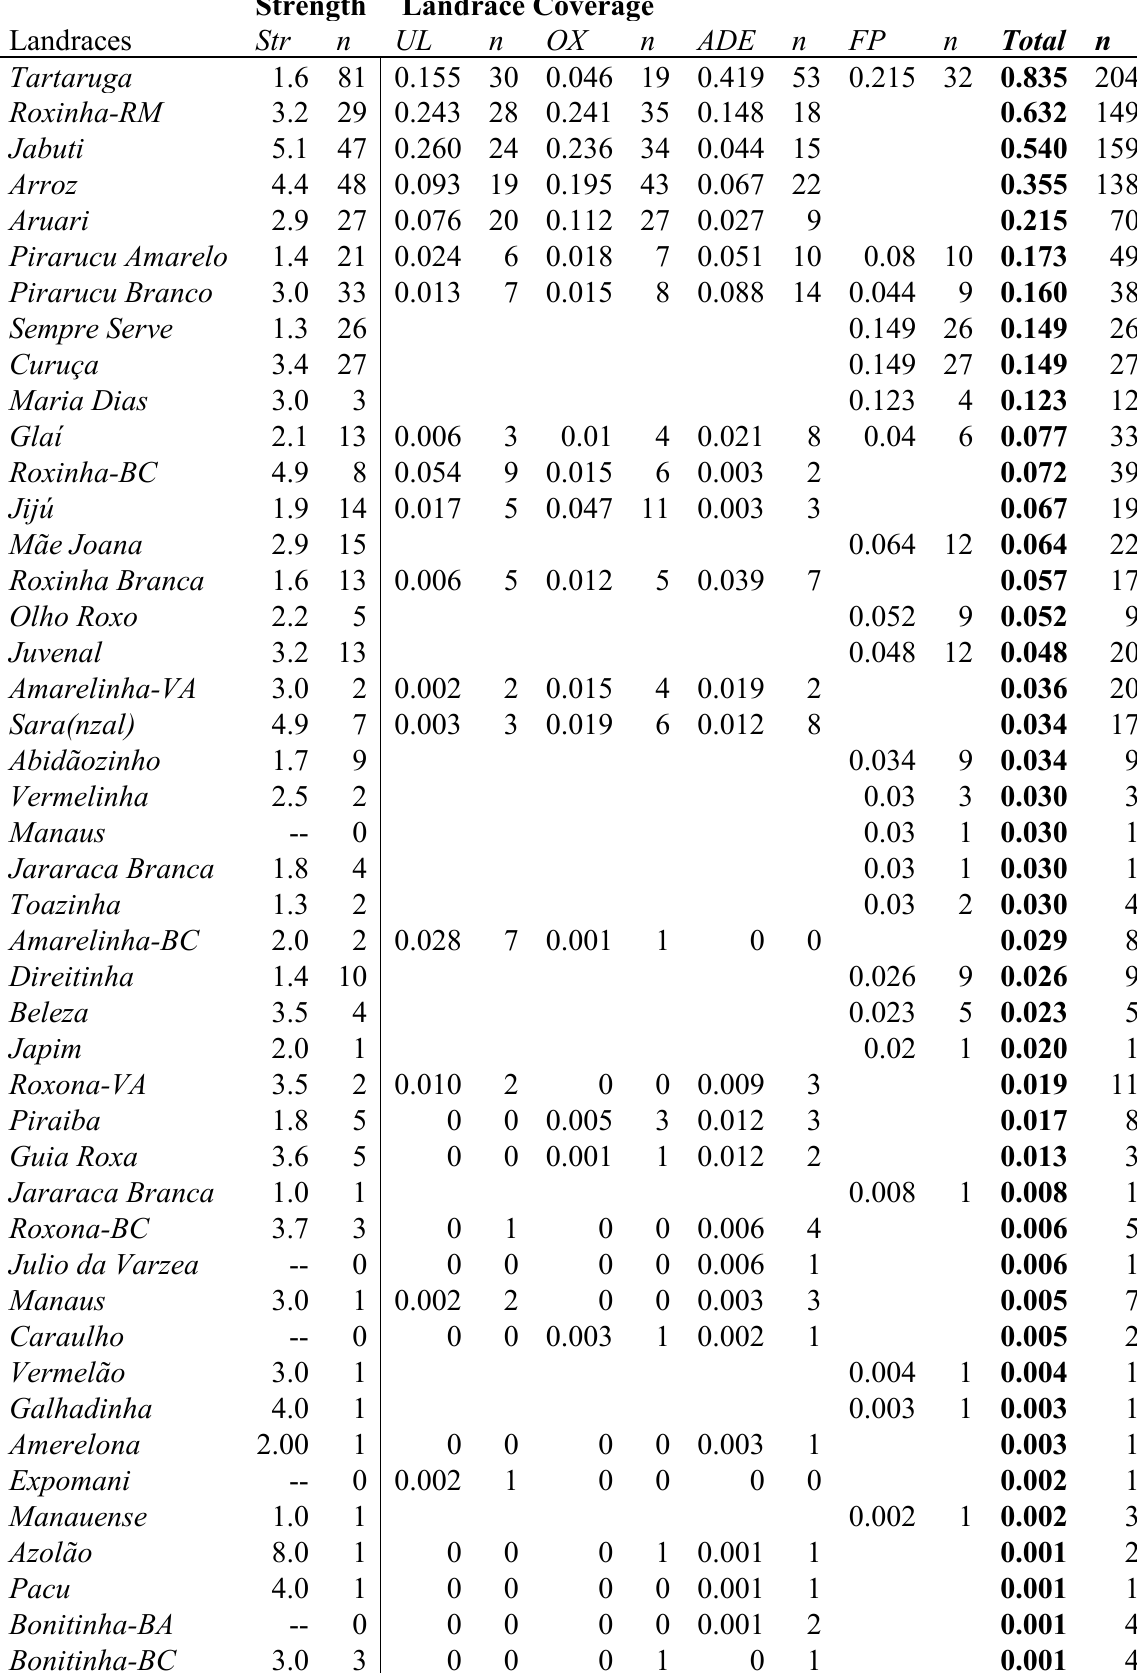
Table 5. Strength and Landrace Coverage for 55 Ultisol fields, 64 Oxisol fields, 71 ADE fields, and 59 floodplain fields along the middle Madeira